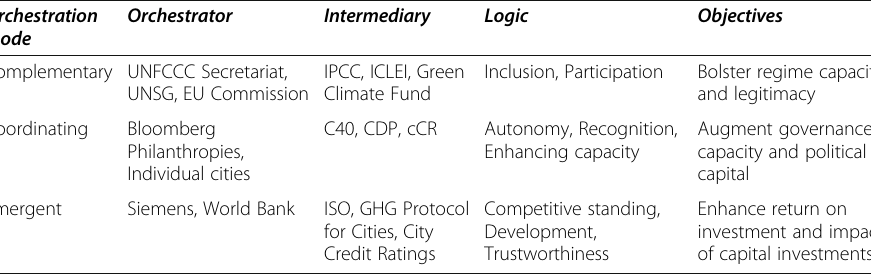
Table 2 Three modes of orchestration Orchestration